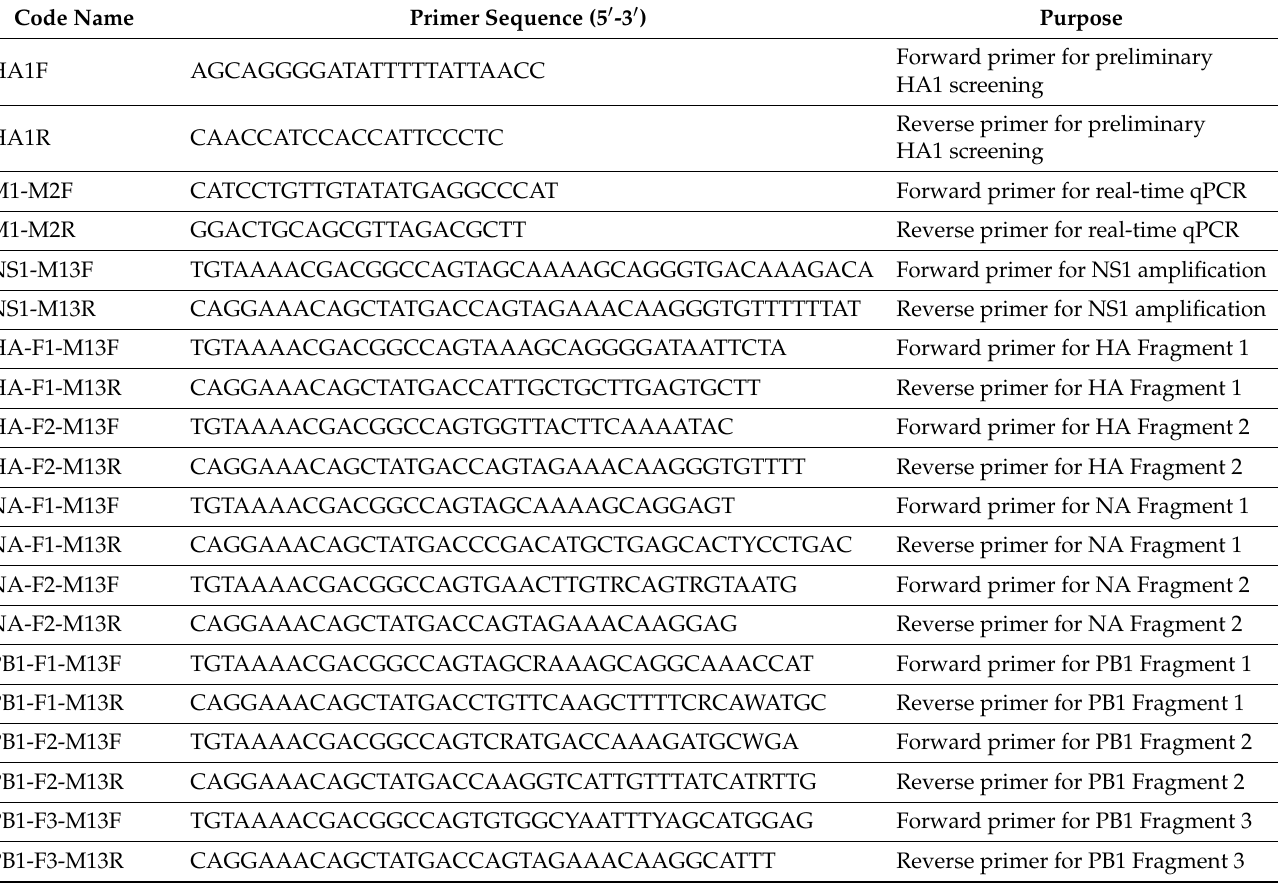
Table 3. List of PCR primers (and their sequences) used in this